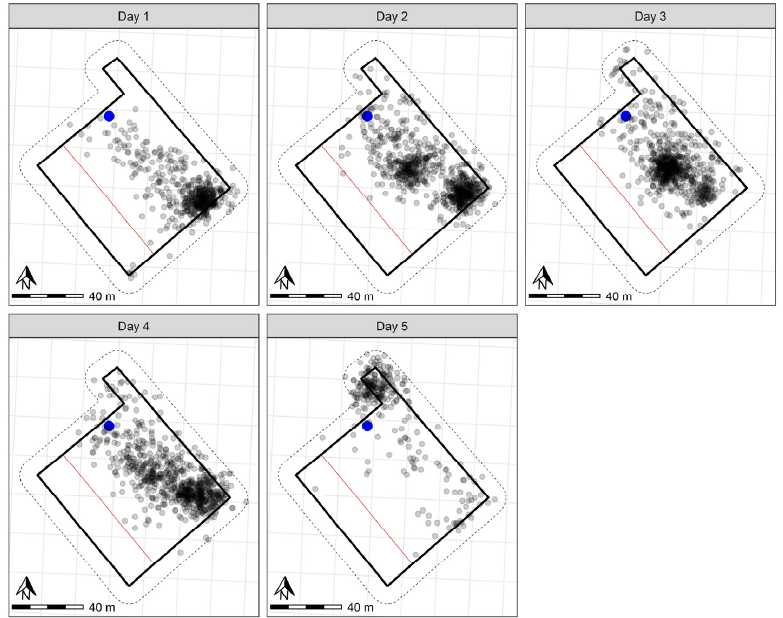
Figure 2. GPS plots per day for six sheep in the five-day Chiswick trial with the water point indicated in blue. The grey points indicate the GPS positions (measured every 10 min) of individual sheep throughout the day. Darker points indicate point overlay in locations where sheep were registered more frequently. The solid black outline indicates the wire fenced paddock boundary. The dashed lines on the outside of the paddock boundary indicate the 10 m buffer zone used to clip the data to remove recording errors based on GPS drift. The red line across the width represents the virtual fence. A scale is included to indicate paddock size.